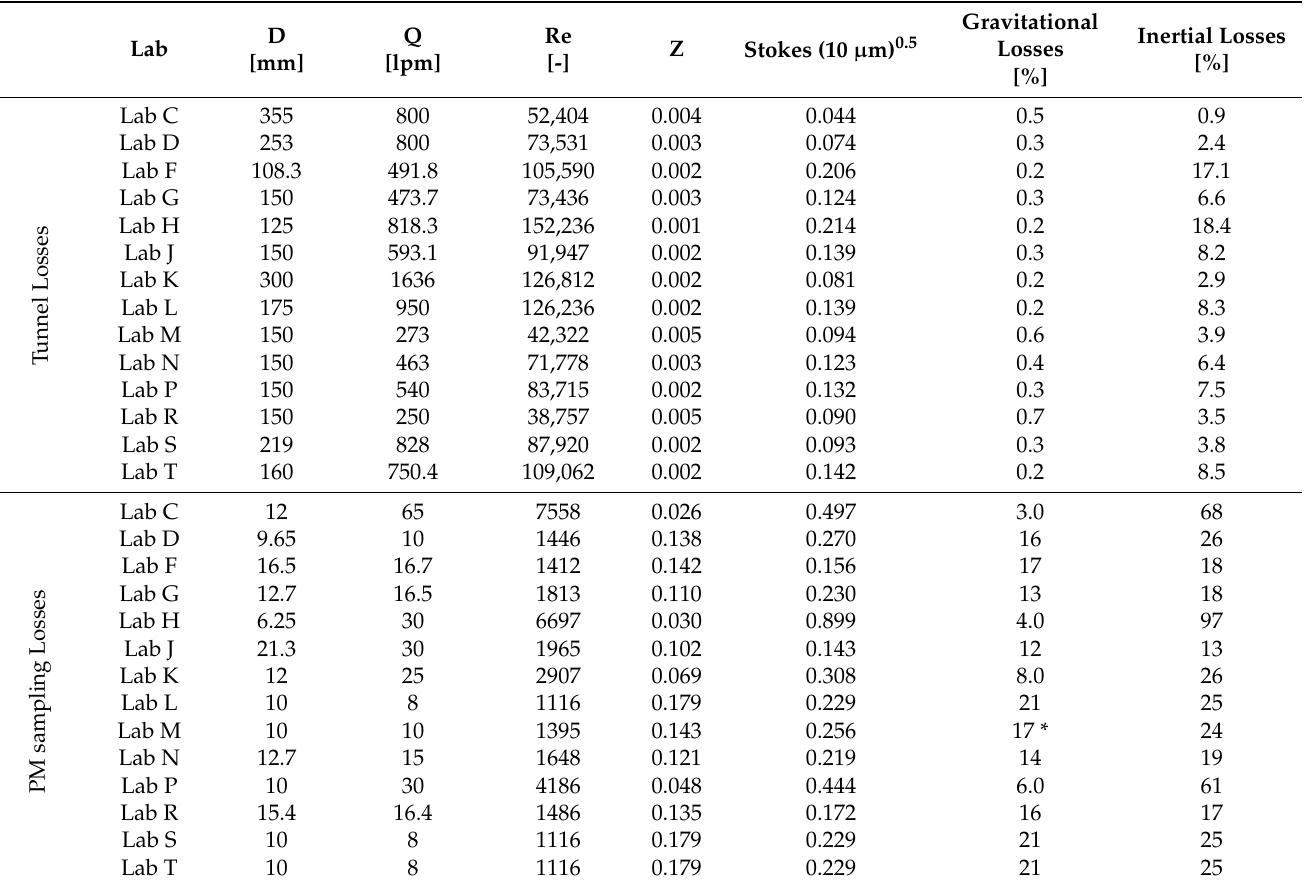
Table 8. Calculation of 10 µ m particle losses in the tunnel, and the PM sampling tube as a factor of the tunnel and tube inner diameters (D), and the tunnel and sampling flow (Q)—V Settling =